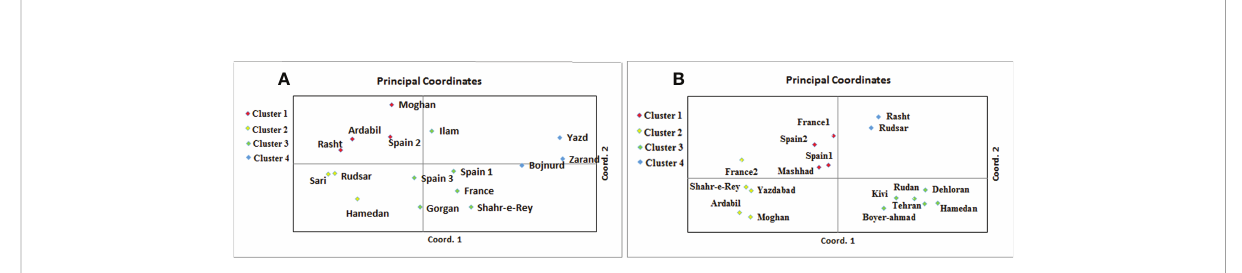
FIGURE 2 Principal coordinates analysis of 16 A . retro fl exus (A) and 17 C . album (B) populations based on the genetic variation revealed by